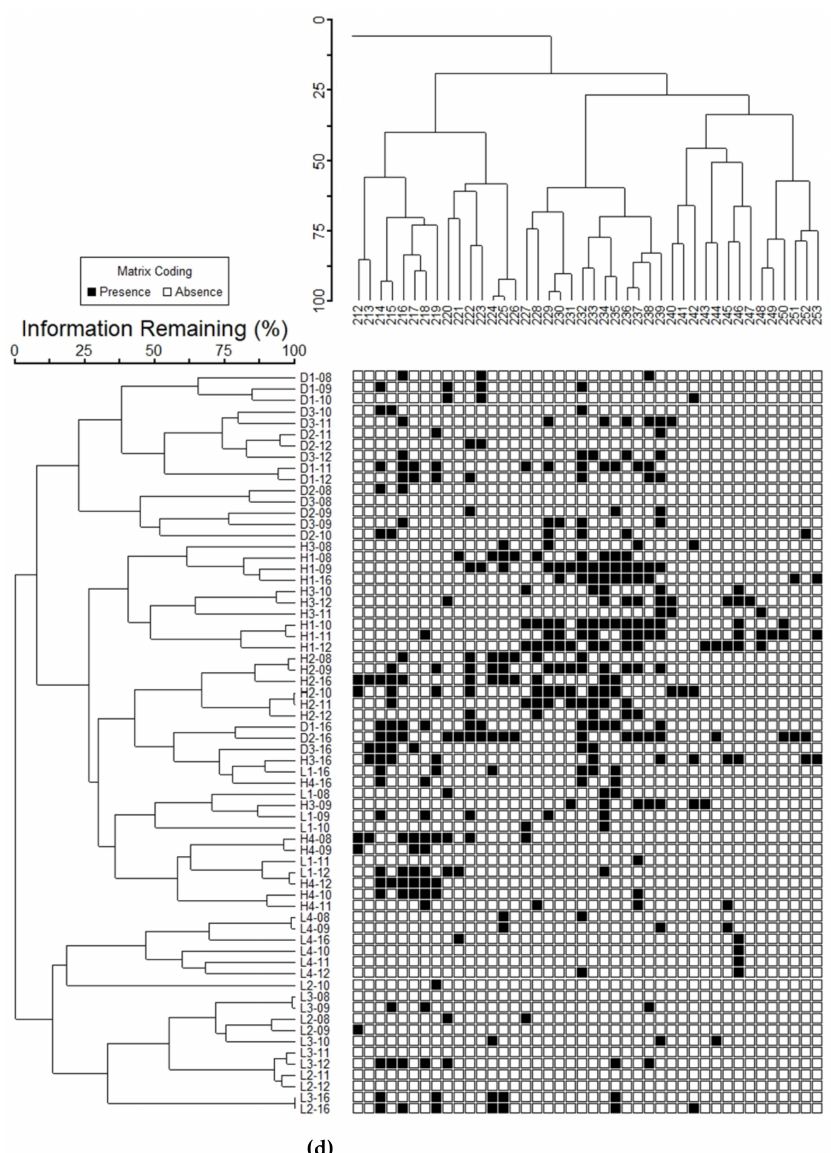
Figure 8. ( a – d ) Two-way classification by agglomerative clustering of 66 reaches and years by 253 macroinvertebrate species at debris flow ( D ), high flood ( H ) and low flood ( L ) reaches from 2008–2012 and 2016 following a large storm in 2007. X-axis labels—Treatment reach and year (e.g., D1-08, D1-09, etc.). Y-axis label—individual species (1–253) (species information in Table 3). Information Remaining—index of community similarity from 0–100. Macroinvertebrate abundances were transformed to presence and absence for analysis. Wide figure is divided into four parts ( a – d